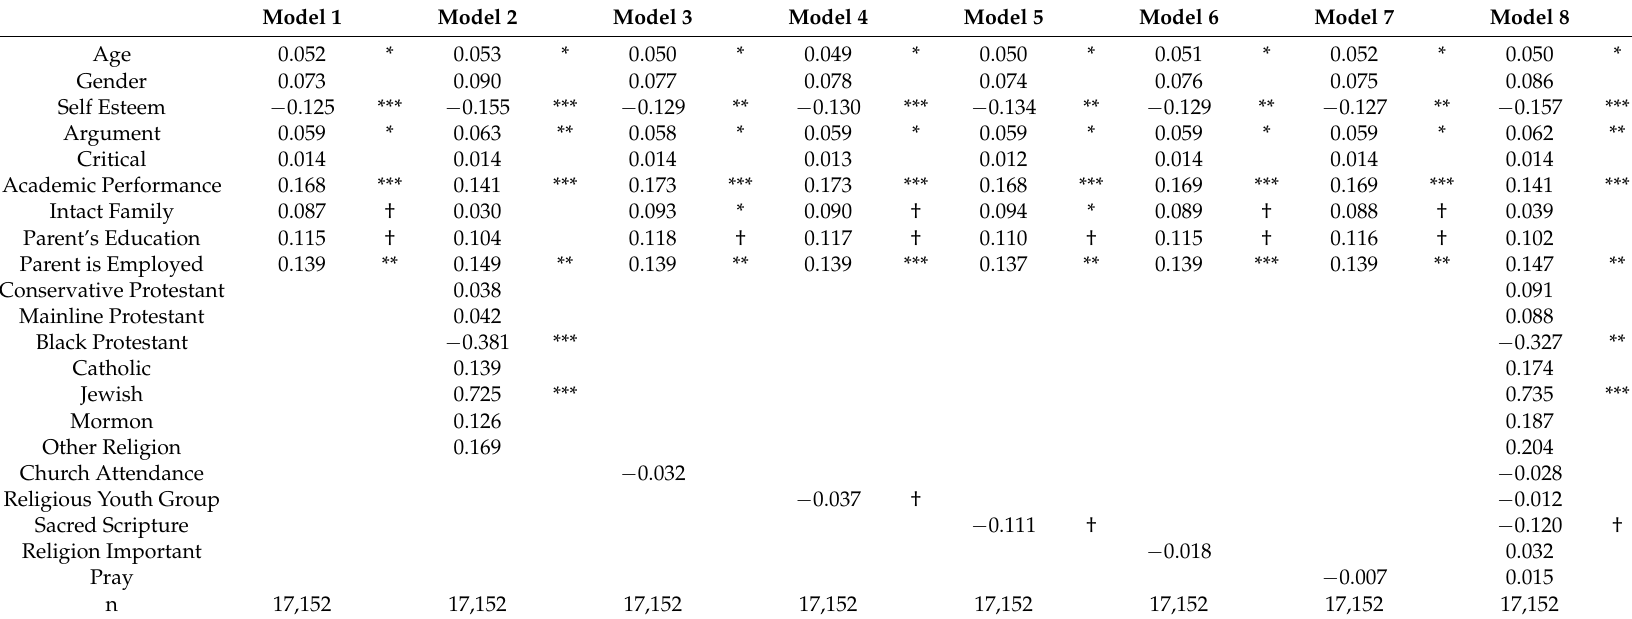
Table 3. Ordered Logistic Regression to Predict Candor.